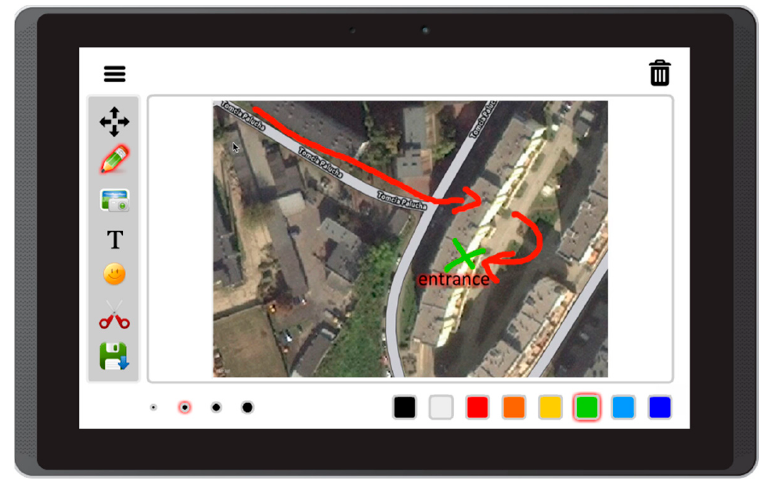
Figure 9. Adding maps and notes in Aphasia Create (screenshot from an Android tablet).